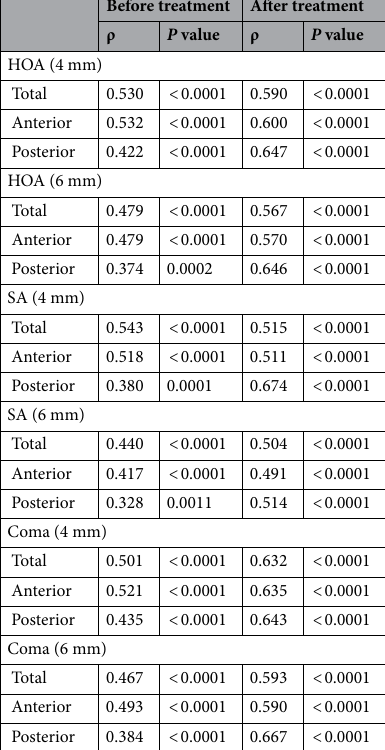
Table 5. Correlations between corneal higher-order aberrations and visual acuities before and after treatment. One patient each with proliferative diabetic retinopathy, advanced glaucoma, and moderate-to-severe cataract were excluded from the analysis of visual acuity. Coma coma aberration, SA spherical aberration, HOA higher- order aberration, ρ Spearman’s rank correlation coefficient.